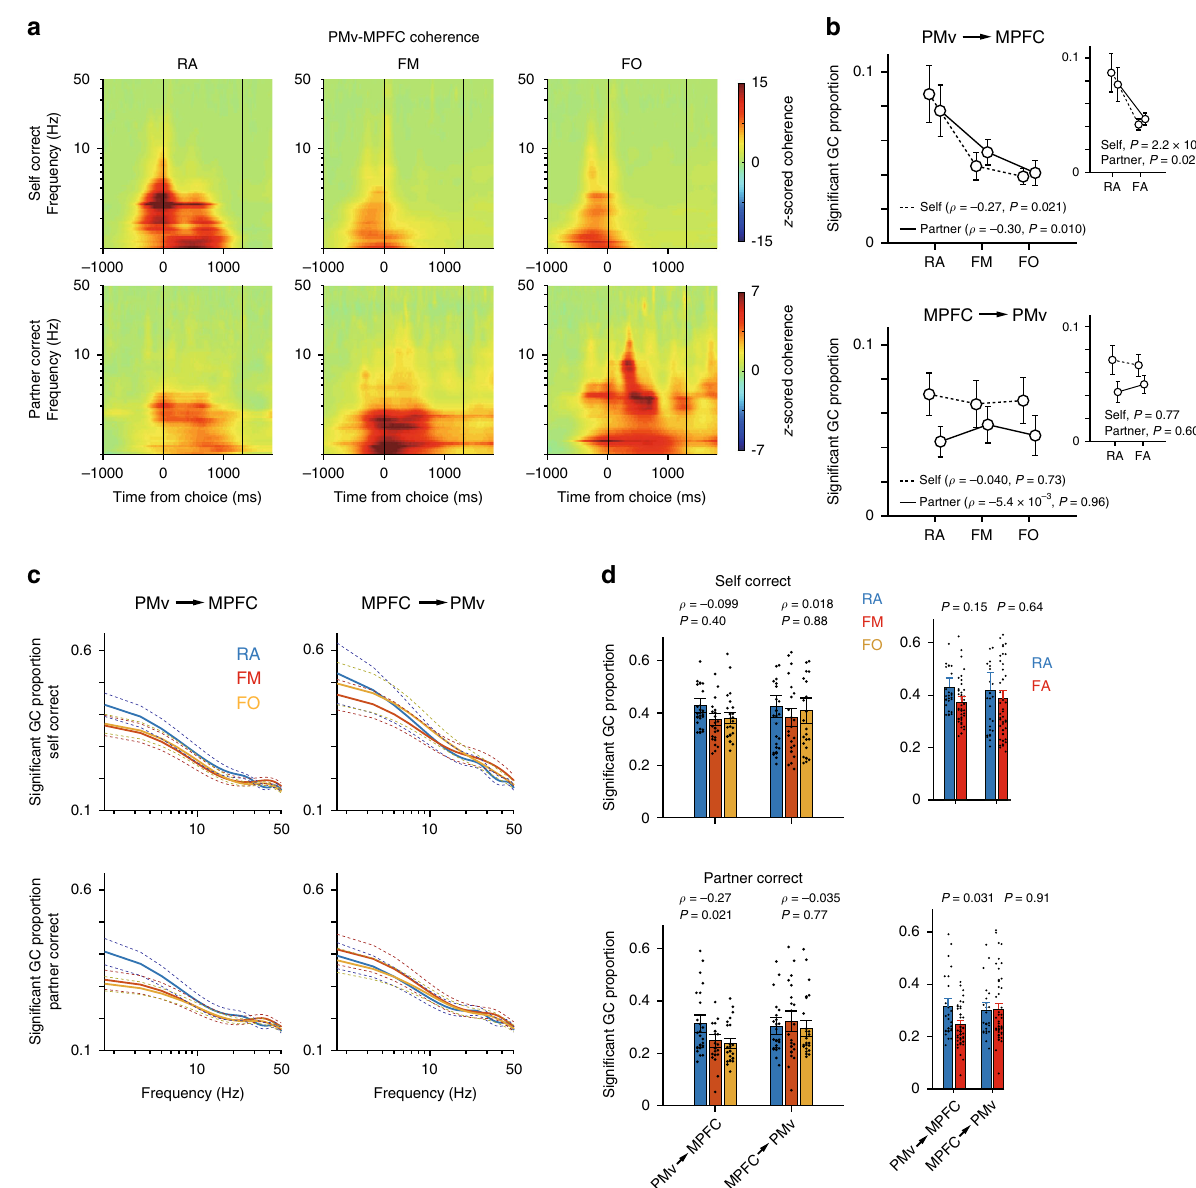
Fig. 5 Coherence and Granger causality between PMv and MPFC. a Coherent activity between the PMv and MPFC [ n = 28 (RA), 24 (FM), 24 (FO) sessions]. Top, self-correct trials; bottom, partner-correct trials. Vertical lines at 1300 ms indicate the time of reward feedback. b Proportions of channel pairs with signi fi cant Granger causality (GC). Median ± s.e.m. [ n = 27 (RA), 24 (FM), 24 (FO) sessions]. Top, PMv-to-MPFC direction; Bottom, MPFC-to- PMv direction. Dotted lines, self-actions; solid lines, partner-actions. ρ and P values, Spearman correlation test (two-sided). Source data are provided as a Source Data fi le. In insets, FM and FO are combined and labeled as FA. Median± s.e.m. P values, Welch ’ s t test (two-sided). Two-way ANOVA for PMv → MPFC; P = 0.53, main effect of actor; P = 3.7 × 10 − 4 , main effect of partner; P = 0.71, actor × partner interaction. Two-way ANOVA for MPFC → PMv; P = 0.034, main effect of actor; P = 0.65, main effect of partner; P = 0.63, actor × partner interaction. c Signi fi cant GC proportions in